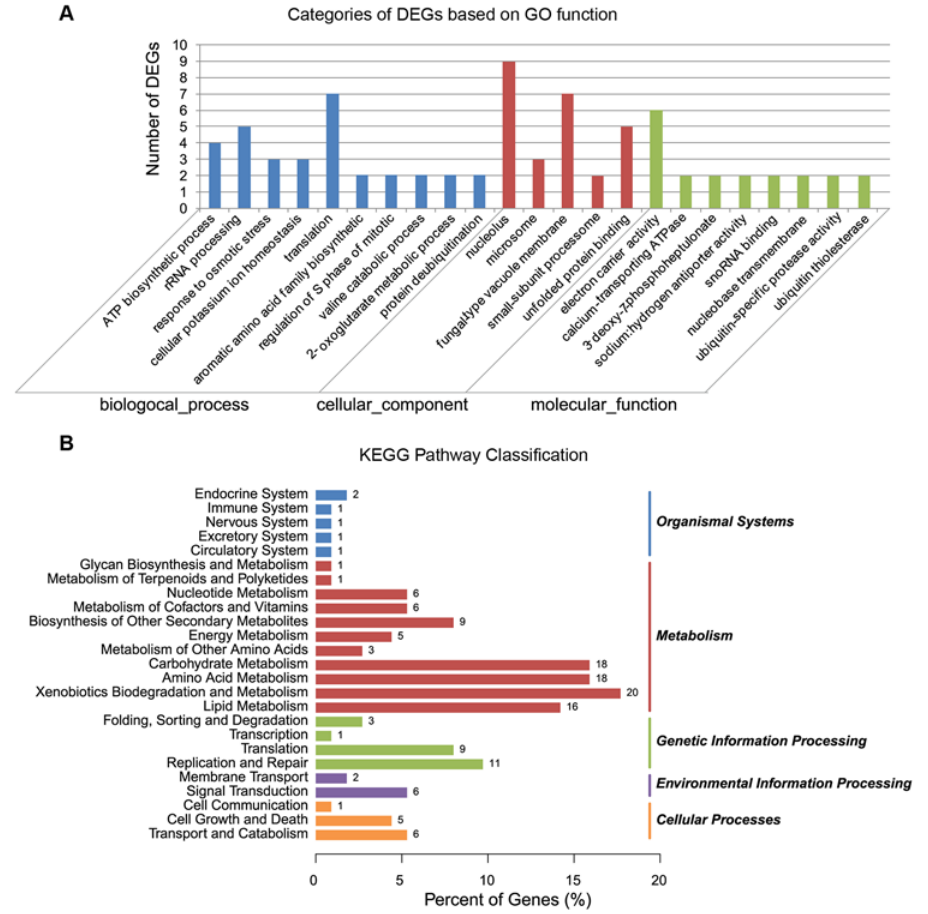
Fig 2. Histogram diagram of Gene Ontology classification. A. Categories of DEGs based on GO function. The results are summarized in three major categories: biological process, cellular component and molecular function. The y-axis on the left indicates the number of genes in a category. B. KEGG pathway classification of identified genes.